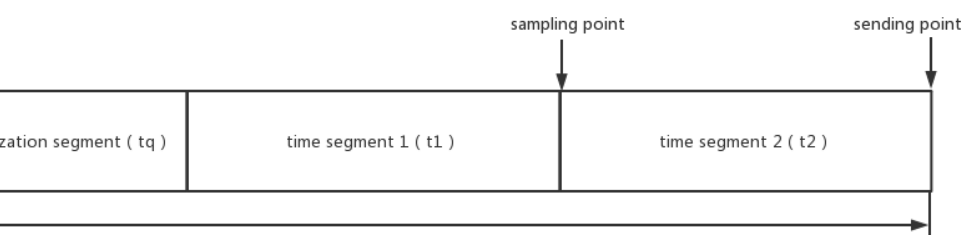
Figure 17. CAN normal bit time.